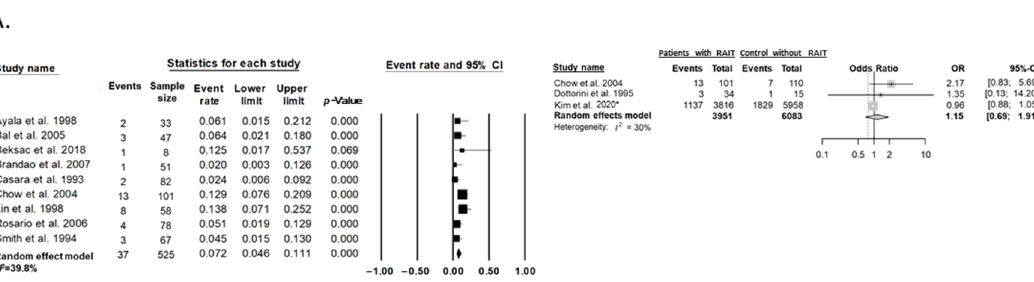
Figure 6. The risk of adverse pregnancy outcomes in patients with an interval of 1 year or more between conception and RAIT. Effect of RAIT on adverse pregnancy outcomes. ( A ) Miscarriage or abortion, ( B ) preterm labor, and ( C ) congenital anomalies. * The study was classified as a case series design because one arm data of patients with thyroid cancer was used in the study. Studies refer- enced: [14,20,22,26,28–36,38–41]. 4. Discussion In this meta-analysis, the risk of adverse pregnancy outcomes, including miscarriage, preterm delivery, and congenital anomalies, did not differ between pregnant women with or without thyroid cancer. In the subgroup analysis, RAIT did not increase the risk of adverse pregnancy outcomes in patients with DTC treated with RAIT when compared with those who did not receive RAIT. In the treatment of DTC, thyroidectomy and RAIT are applied as standard treatments [5]. Total thyroidectomy can lead to postoperative hypothyroidism. In addition, postop- erative hypothyroidism reportedly occurs in approximately 30% of patients even after subtotal thyroidectomy [43]. Considering that many patients with DTC undergo thyroid hormone suppression therapy, these patients may experience various thyroid functional statuses (euthyroid, subclinical/overt, hyperthyroid, or hypothyroid) according to the in- dividual thyroid-stimulating hormone target or compliance with levothyroxine [44]. Based on studies emphasizing that subclinical hyperthyroidism is not associated with maternal or neonatal complications, the American Thyroid Association recommends that patients with thyroid cancer maintain the same thyroid-stimulating hormone goal before and during pregnancy [5]. Nevertheless, epidemiological studies on the effects of